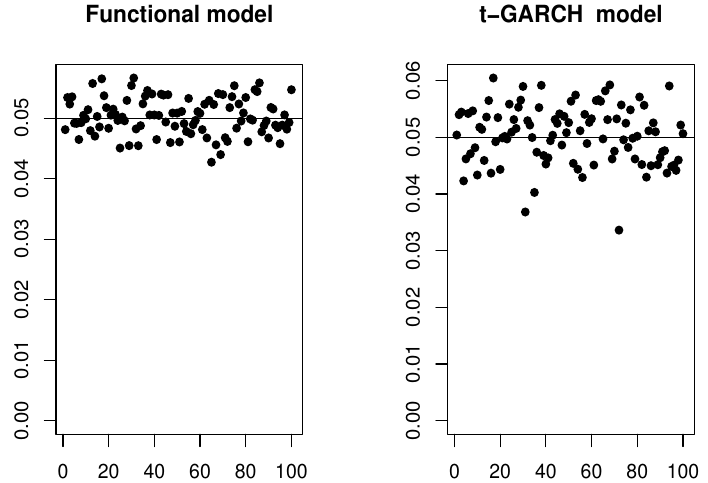
Figure 6. Comparison of the p -values between t-GARCH nonparametric functional